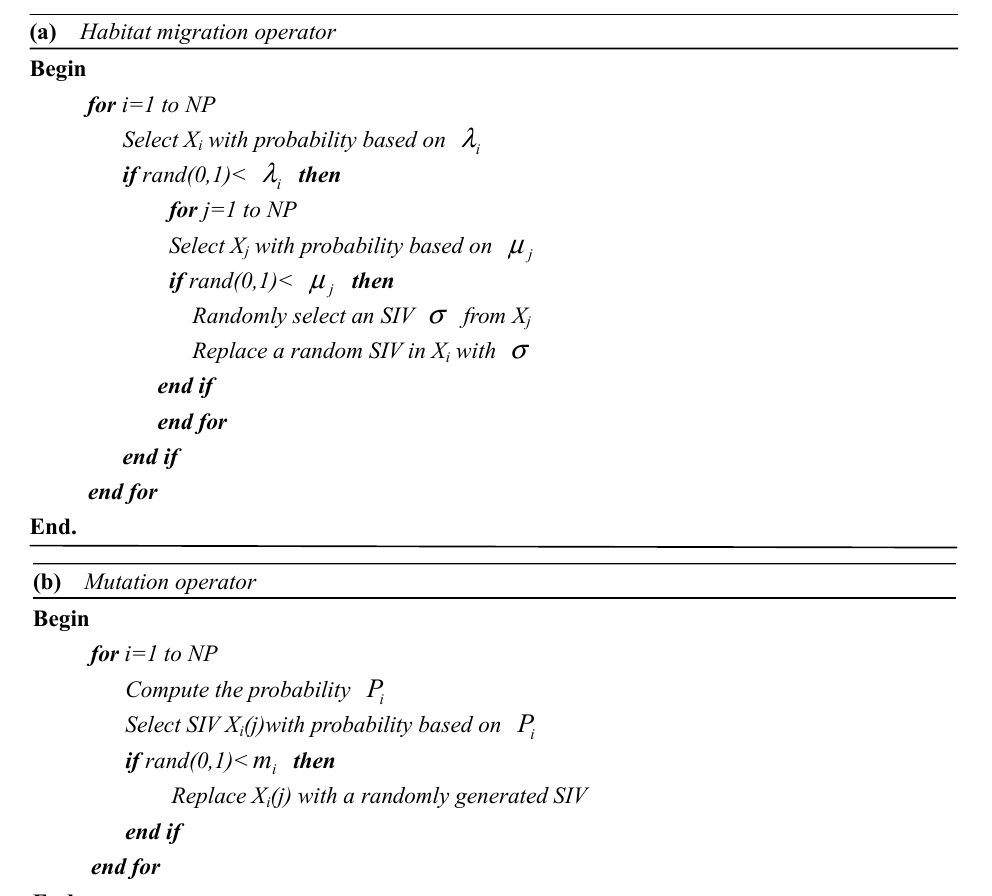
Figure 1. ( a ) The habitat migration operator algorithm. ( b ) The habitat mutation operator